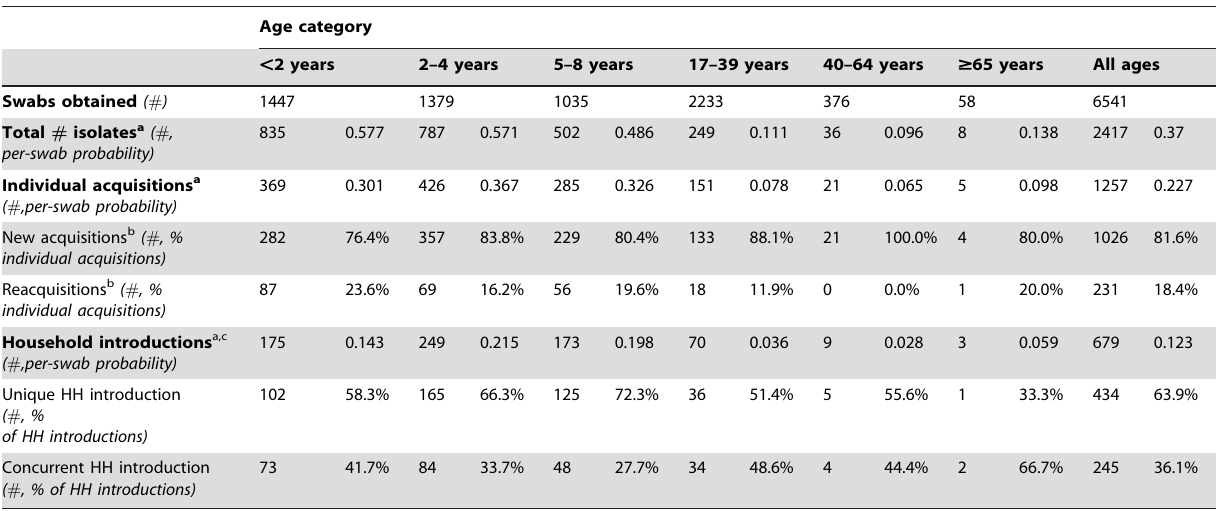
Table 2. Summary of pneumococcal acquisition events by age